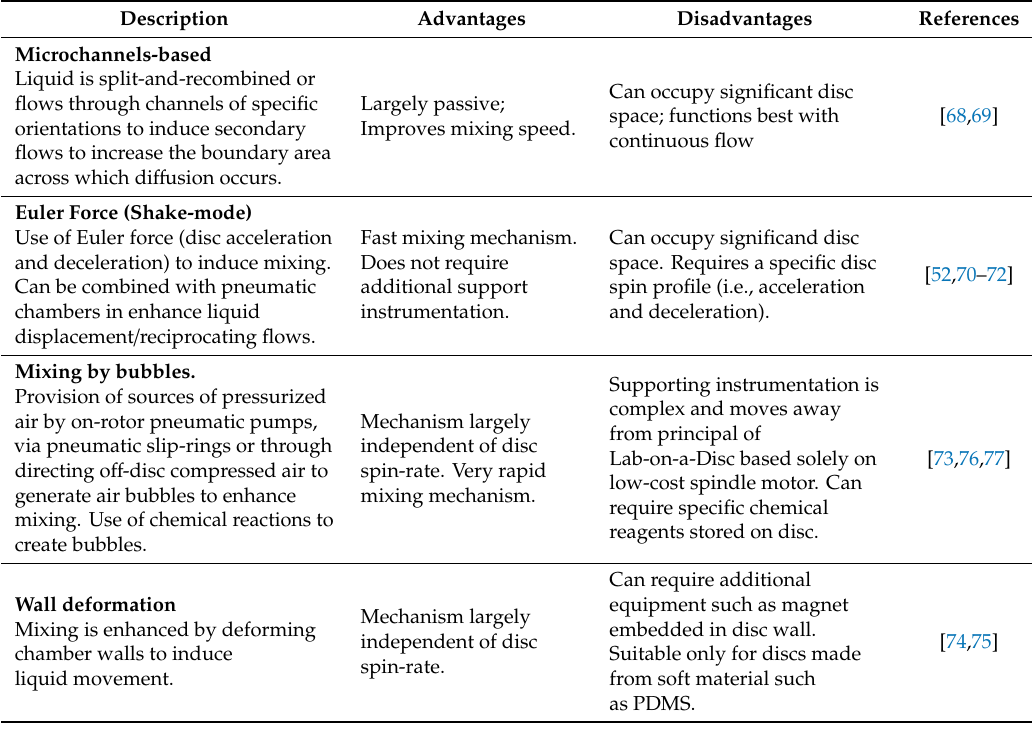
Table 1. Comparison of Mixing Mechanisms in Centrifugal